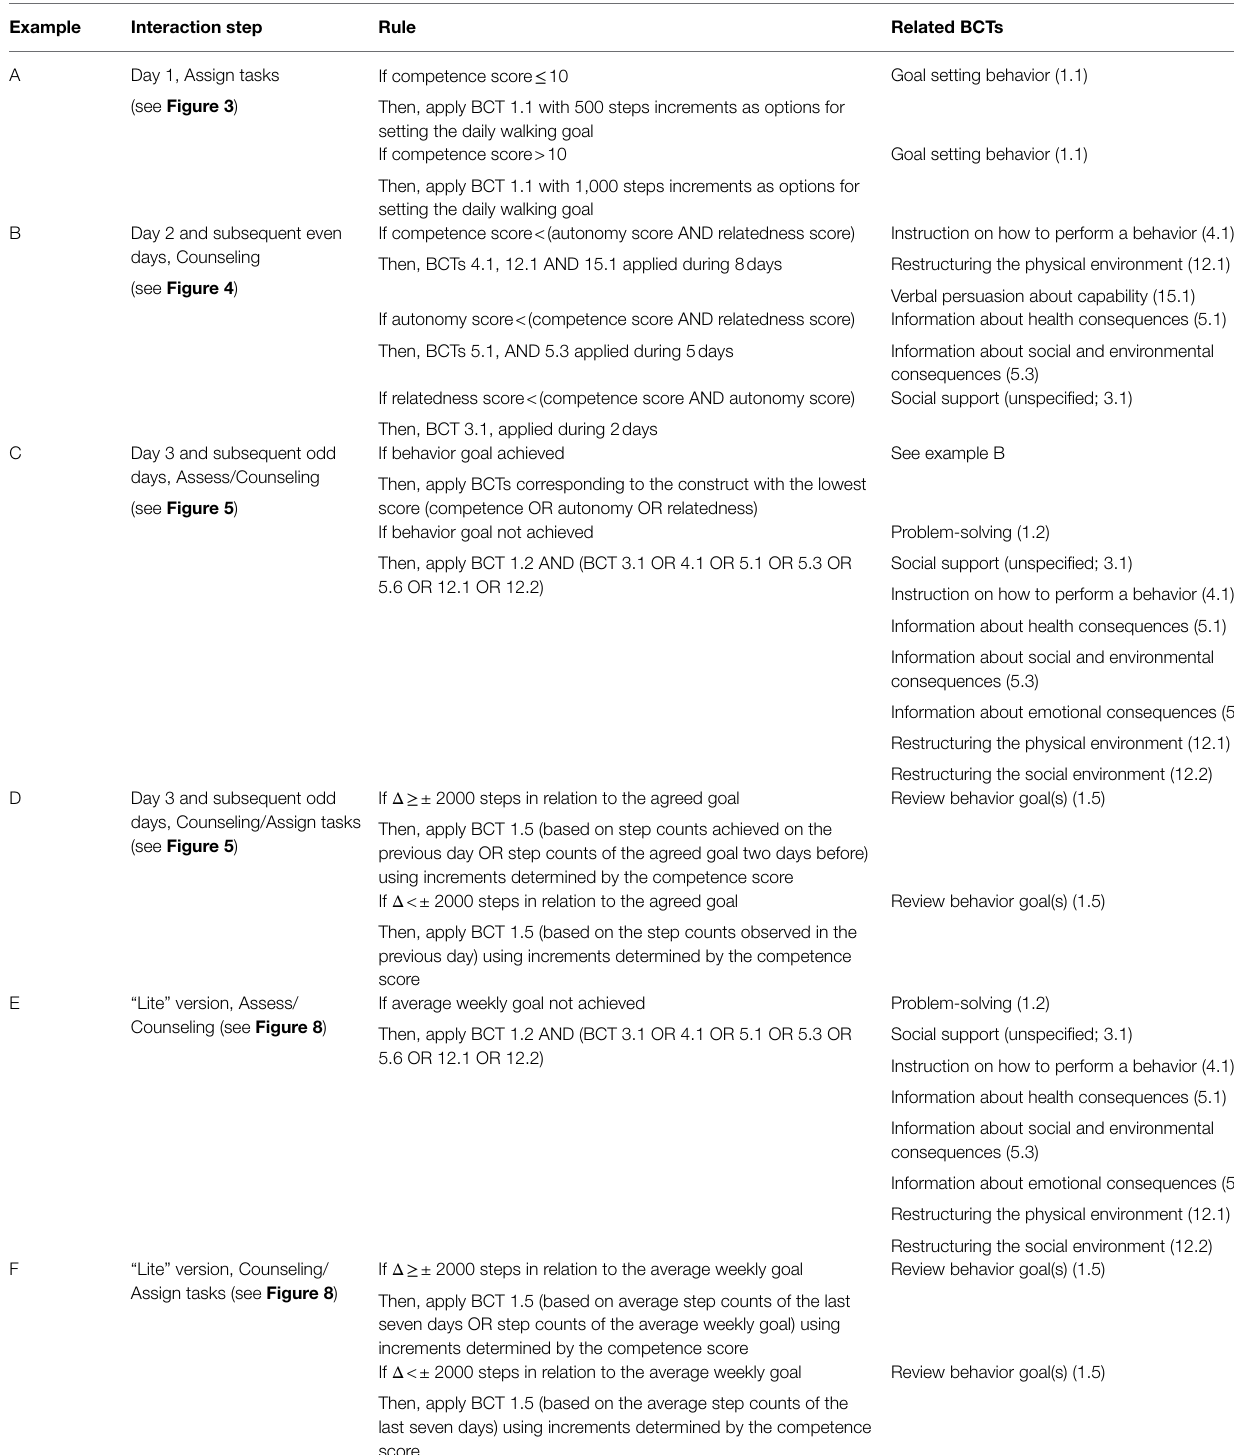
TABLE 2 | Decision rules for tailoring